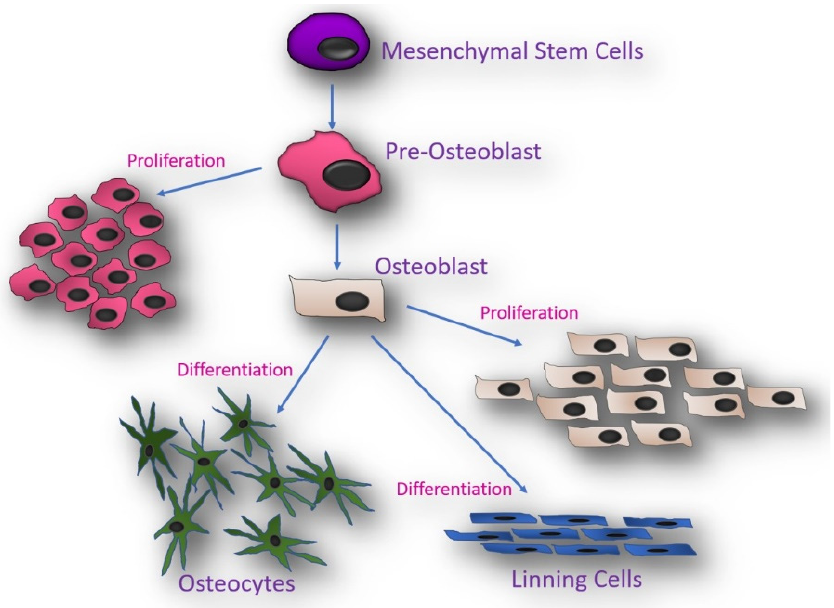
Figure 2. Development of bone precursor cells (mesenchymal stem cells, preosteoblasts, osteoblasts, mature osteocytes, and osteoclasts). This process is primarily mediated by osteoblasts. Both the proliferation and differentiation of osteoblast progenitors are essential for bone growth and development. Since the prolonged cell cycle of 45,X cells leads to fewer cell clones over time, the proliferating osteoblast progenitor population is affected, leading to a reduction in the number of bone-forming cells. Decreased proliferation of bone precursor cells might affect both bone mineralization and the skeleton (bone dysmorphogenesis and short stature).